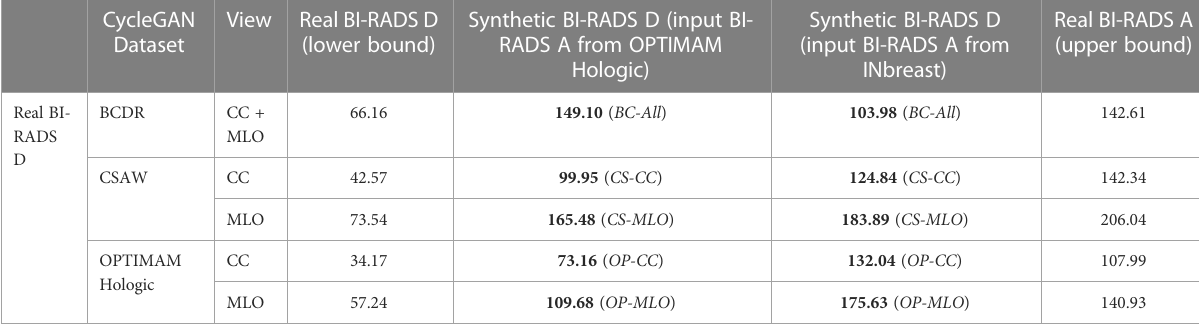
TABLE 2 Fre ́ chet Inception Distance between different sets of